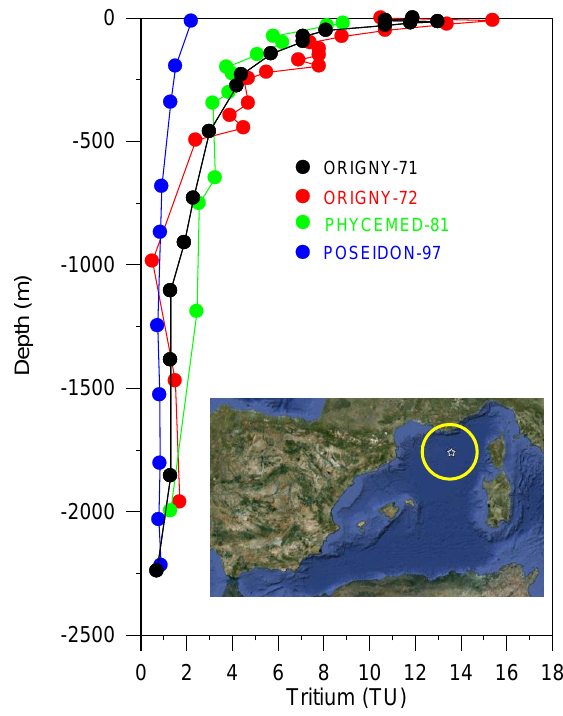
Fig. 6. Tritium profiles in 1971–1972, 1981 and 1997 in the WMed, for positions see inset